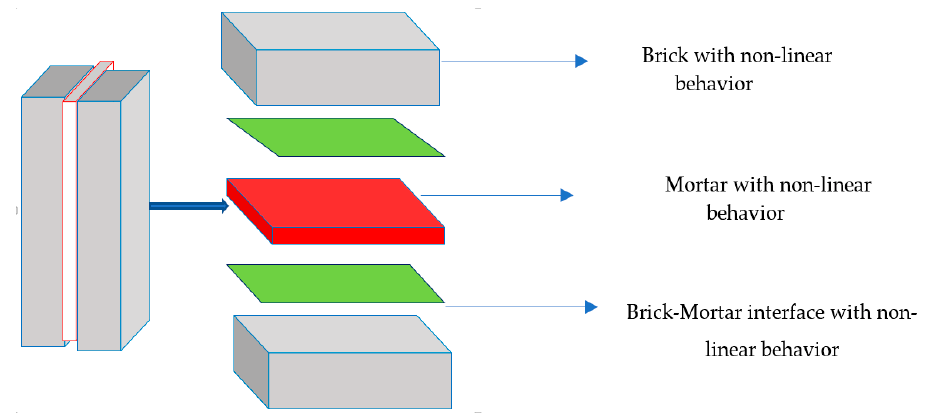
Figure 9. Adopted detailed micro-modeling (DMM) approach.